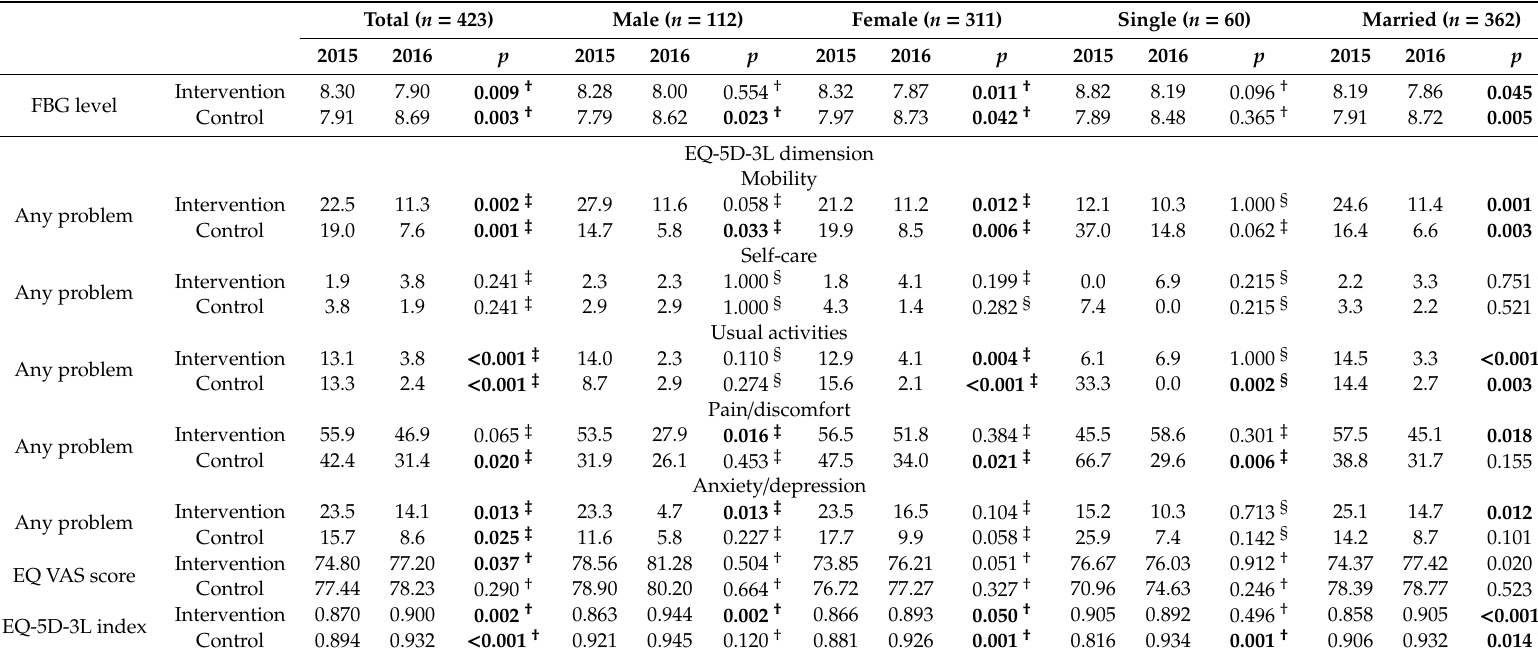
Table 2. Fasting blood glucose (FBG) level (mmol / L, mean value), prevalence (%) of any problems by EQ-5D-3L dimensions, EQ visual analogue scale (VAS) score (mean), and EQ index value (mean) for the intervention group ( n = 213) and control group ( n = 210) at baseline (2015) and follow-up (2016) for the total group and stratified by sex and by marital